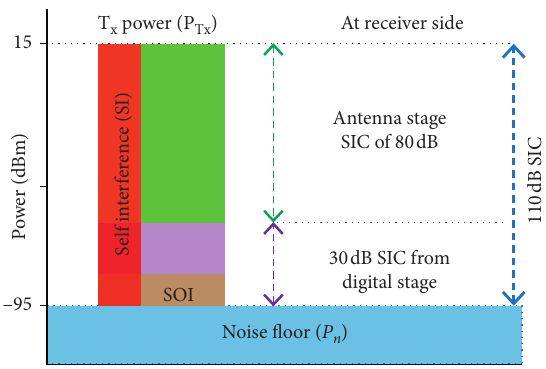
Figure 1: Achieving around 110 dB self-interference cancellation (SIC) for an IBFD transceiver with 80dB and 30 dB SIC at antenna and digital baseband stages,